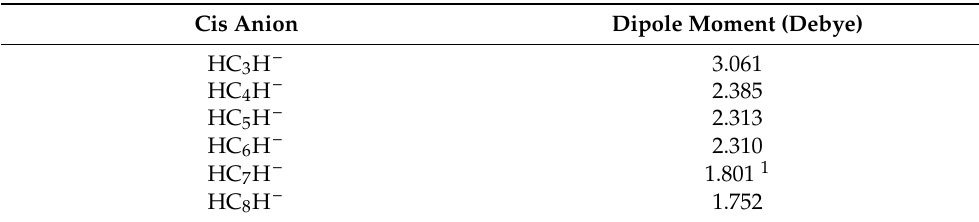
Table 4. Dipole moment µ of anion’s cis isomers computed via single-point ROCCSD(T) calculations at the geometry optimized via UB3LYP/6-311++G(3df,3pd).